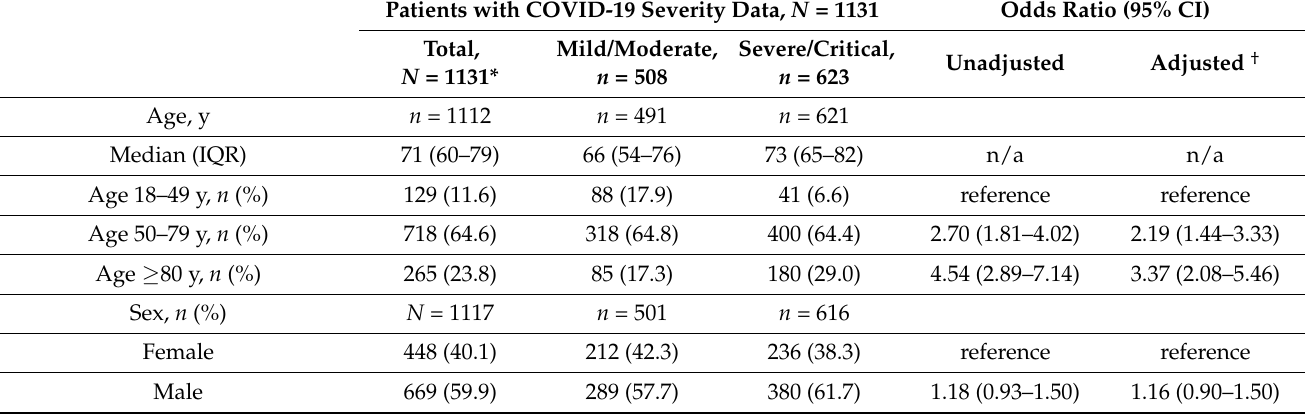
Table 3. Baseline characteristics of, and therapy received by, patients with hematologic malignancies according to COVID-19 clinical